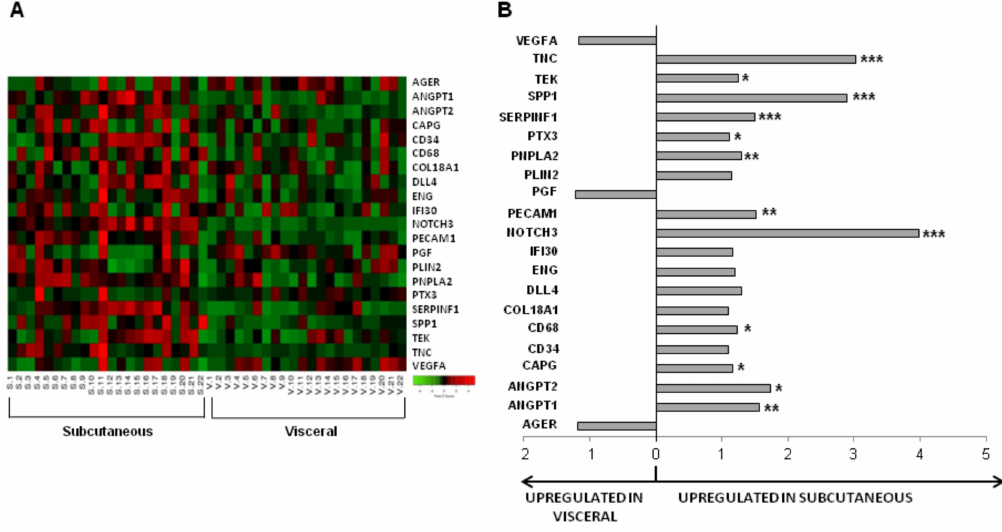
Figure 3. ( A ) Heat map of the gene expression in subcutaneous versus visceral fat; ( B ) Fold change of gene expression in subcutaneous versus visceral fat. * p < 0.05; ** p > 0.01; and *** p <